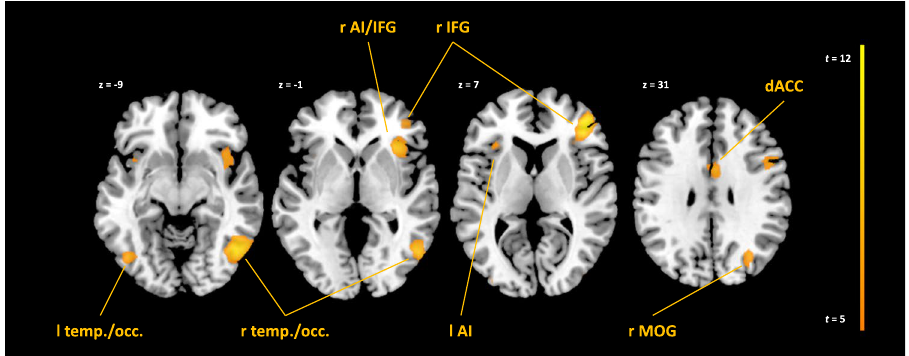
Figure 2. Conjunction Self > Friend & Self > Stranger , full Sample, p FWE < 0.05. l = left, r = right. AI = anterior insula, IFG = inferior frontal gyrus, dACC = dorsal anterior cingulate cortex, MOG = middle occipital gyrus. Plane identifiers are in MNI space.